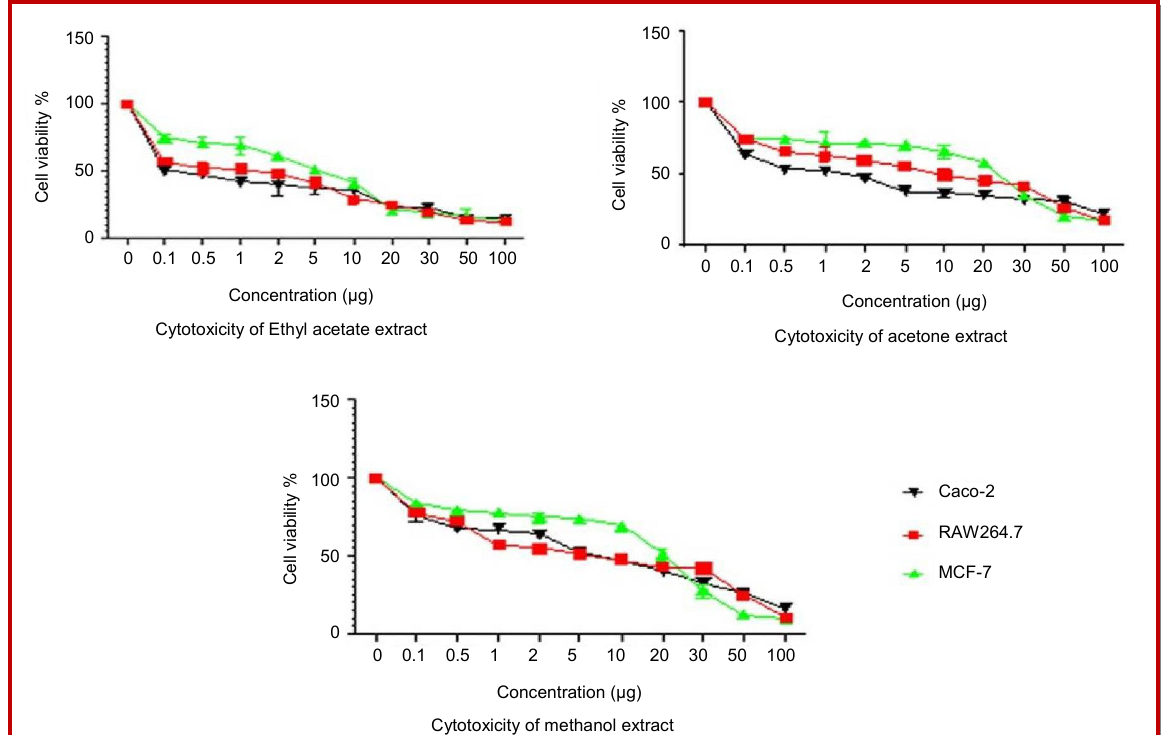
Figure 7: Percentage viability of different cell lines due to P. mollis extracts in MTT